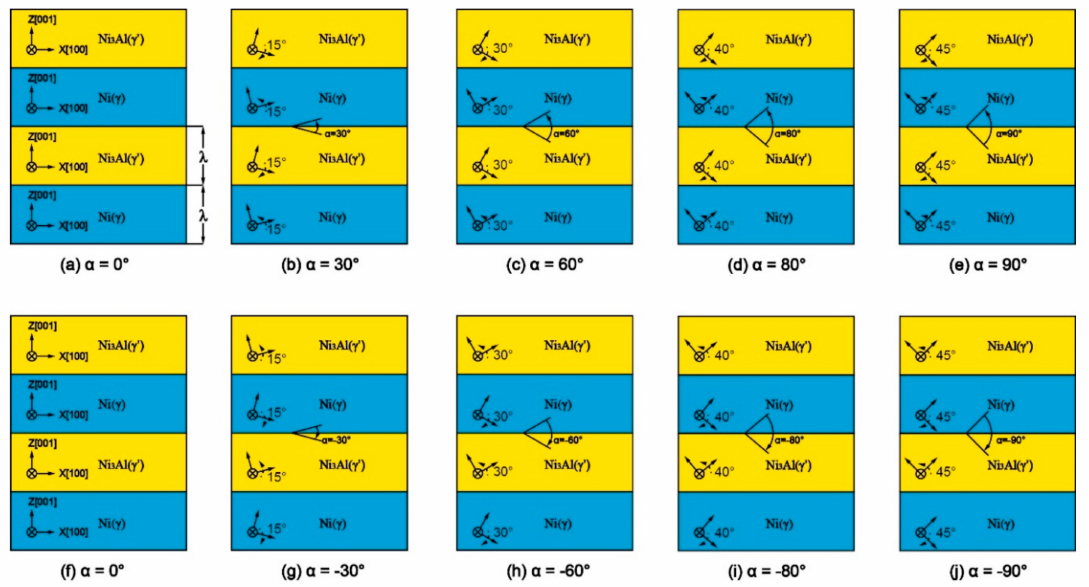
Figure 1. Models of Ni / Ni 3 Al multilayers ( λ = 88.66 Å): ( a ) α = 0 ◦ ; ( b ) α = 30 ◦ ; ( c ) α = 60 ◦ ; ( d ) α = 80 ◦ ; ( e ) α = 90 ◦ ; ( f ) α = 0 ◦ ; ( g ) α = − 30 ◦ ; ( h ) α = − 60 ◦ ; ( i ) α = − 80 ◦ ; ( j ) α = − 90 ◦